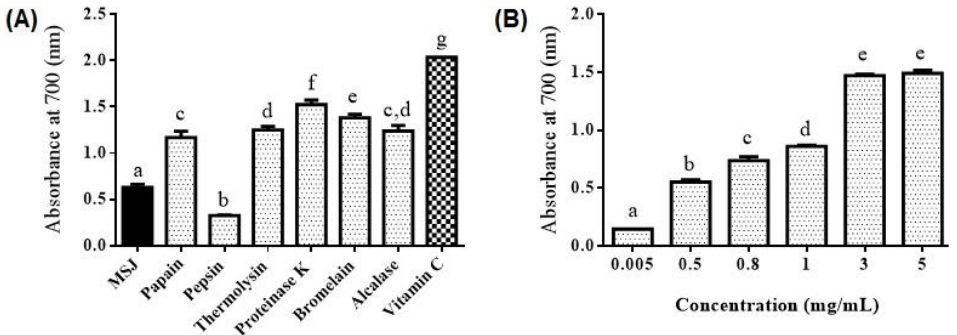
Figure 10. ( A ) Reducing power of mackerel steaming juice (MSJ), MSJ hydrolysates and vitamin C. The concentration of MSJ, MSJ hydrolysates and Vitamin C are at 5, 5, 0.05 mg/mL, respectively. ( B ) Reducing power of proteinase K hydrolysates with different concentration. Different alphabets on the bar show significant difference at p <